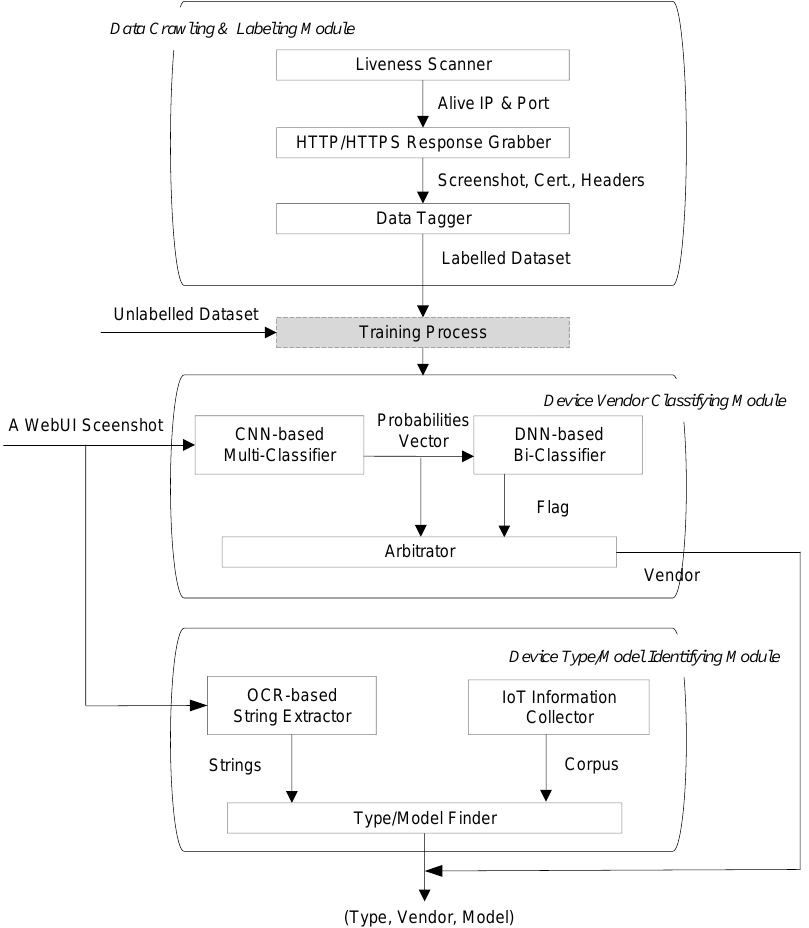
Figure 2. Framework for IoT device identification.